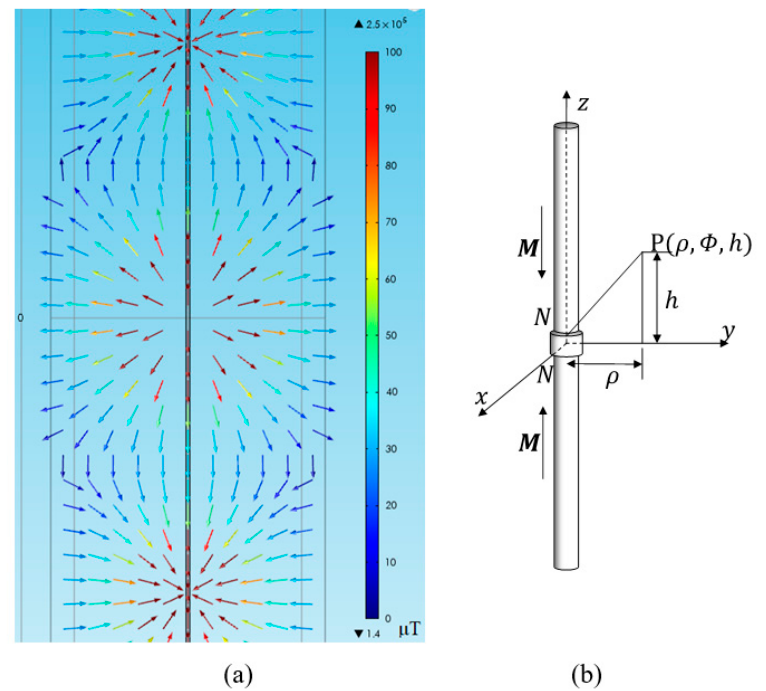
Figure 3. Magnetic field distribution around a casing string with homogeneous magnetic pole connection. ( a ) Magnetic field distribution; ( b ) casing string with N–N connection.